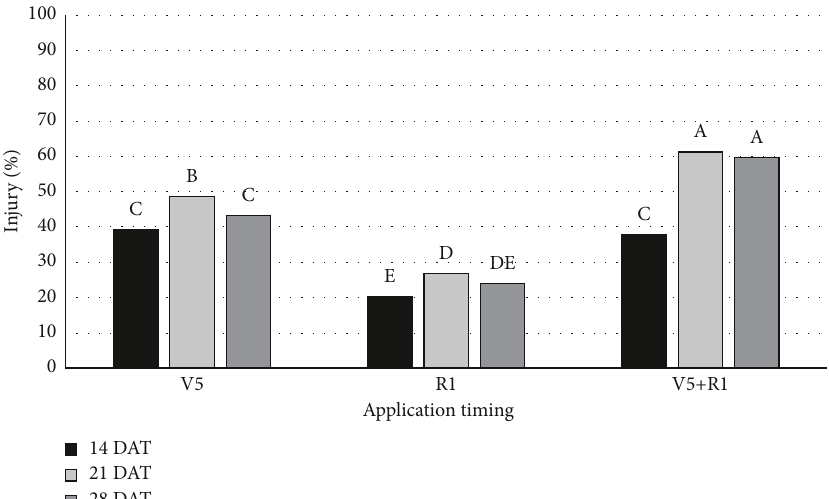
Figure 2: Injury of soybean according to the interaction of application timing and rating date in days after treatment (DAT) for the irrigation experiments conducted in Fayetteville and near Colt, AR, in 2019. Treatments with the same uppercase letter are not significantly different according to Fisher’s protected least significant difference α